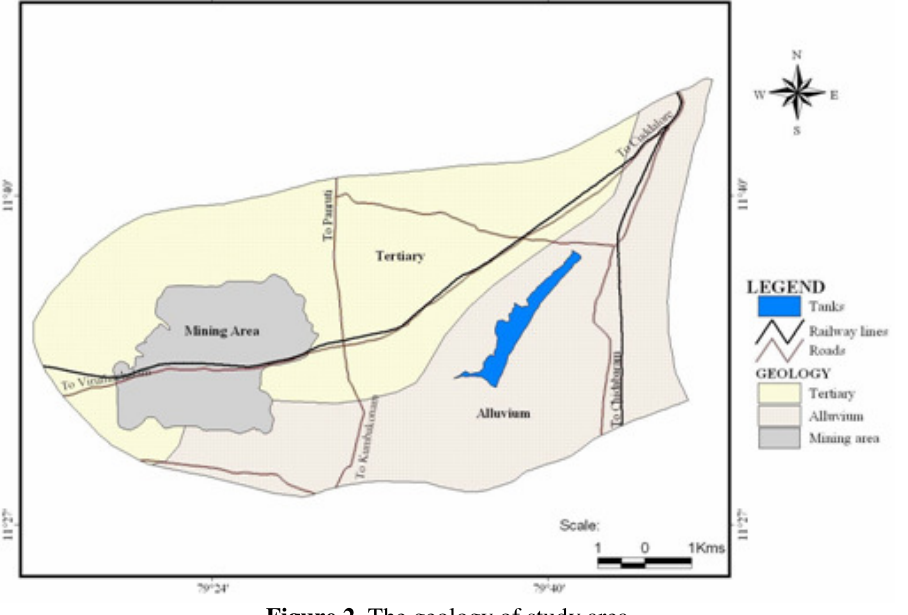
Figure 2. The geology of study